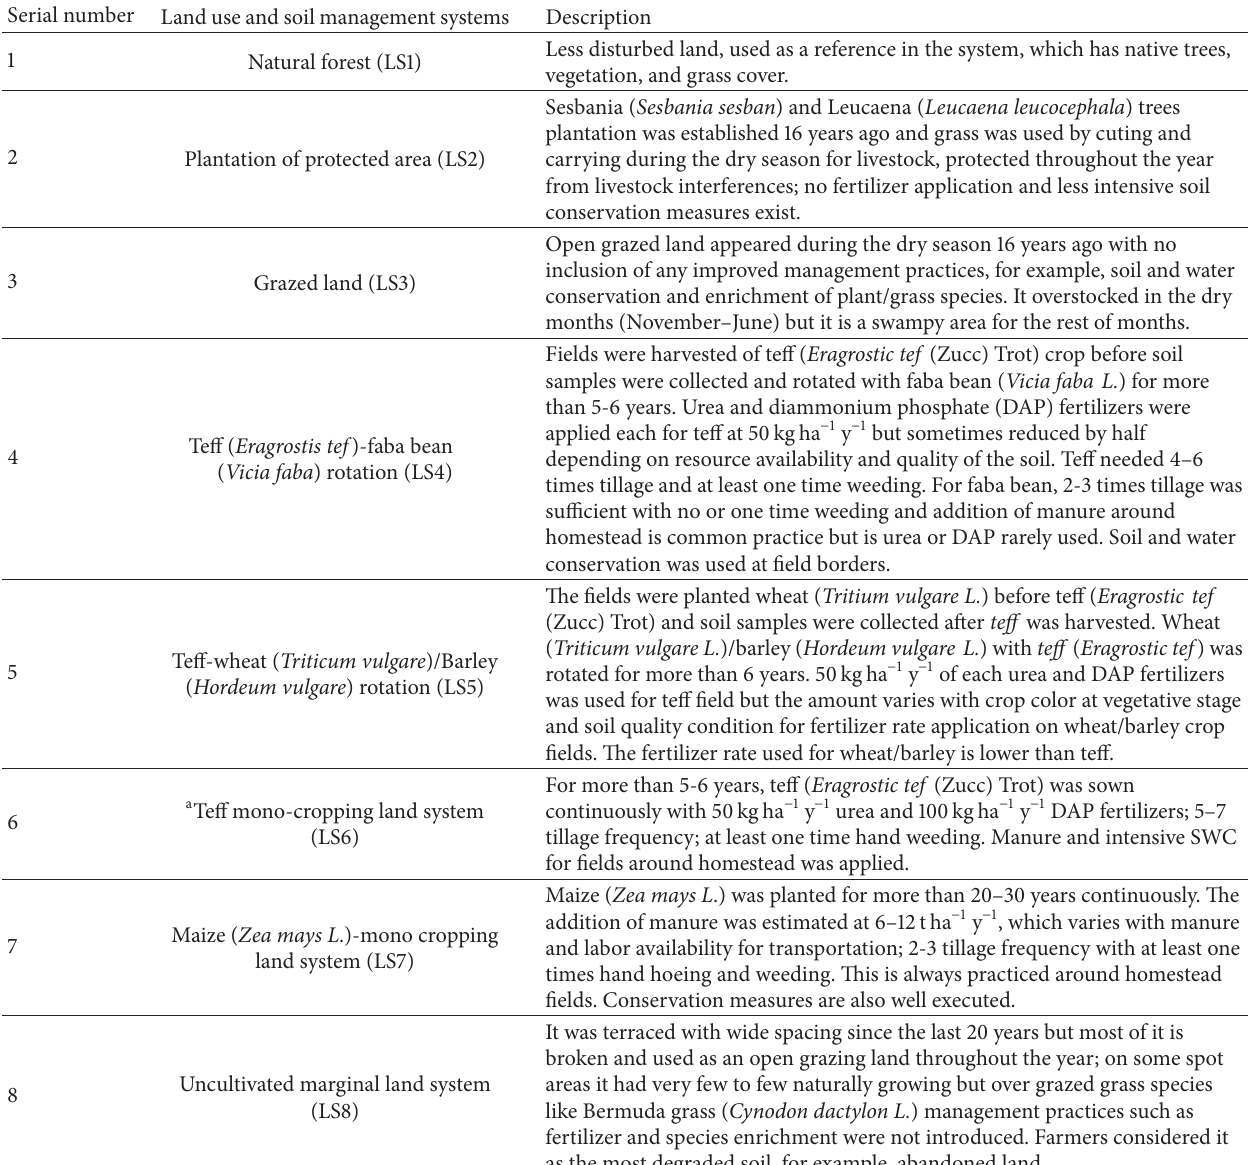
Table 2: Description of the eight land use and soil management systems (LUSMS) evaluated within the Mai-Negus catchment in northern